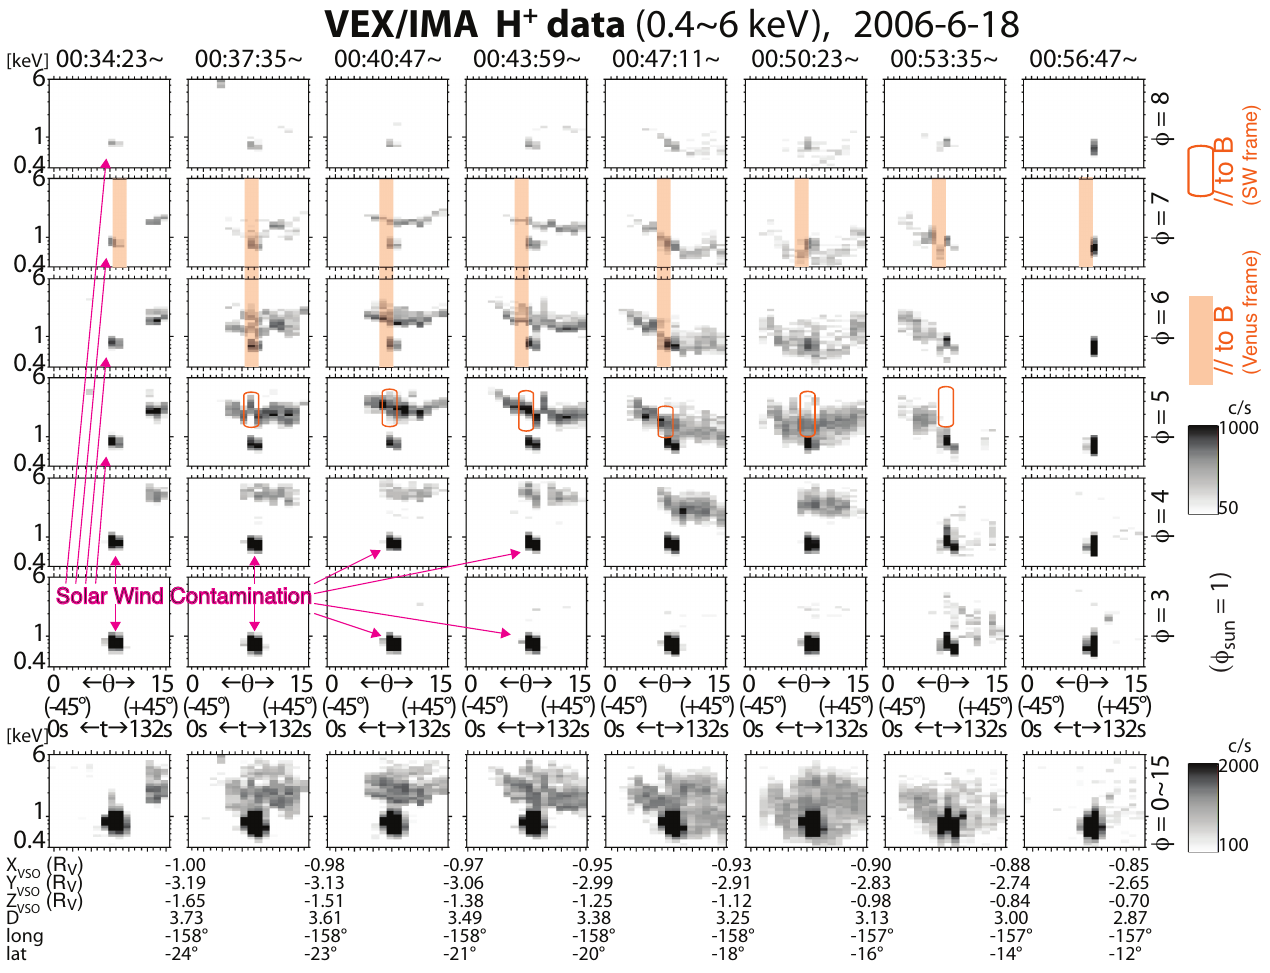
Fig. 4. Energy-angle spectrograms from VEX/IMA proton channels (0 . 4 ∼ 6keV) on 18 June 2006 as they progress over time during 00:34:23 ∼ 00:59:59UT (part of Fig. 3). The ion species (proton) is confirmed by the energy-mass matrix (not shown here). Six different azimuthal sectors (from top to bottom φ = 8, 7, 6, 5, 4, 3) are shown for each 192s scanning cycle in elevation, such that each window corresponds to an elevation-energy spectrogram for elevation angles − 45 ◦ ∼+ 45 ◦ ( θ = 0–15). The magnetic field direction in the spacecraft frame is indicated by filled red squares. Although the magnetic field direction is about the same between the spacecraft frame and the solar wind frame, the field-aligned direction for ions in the solar wind frame is shifted by the solar wind velocity (cf. Fig. 5, marked by empty orange squares). The energy dependency of this direction ( θ and φ ) is very weak for the foreshock ions that we discuss here, because the field-aligned velocity of these ions is very